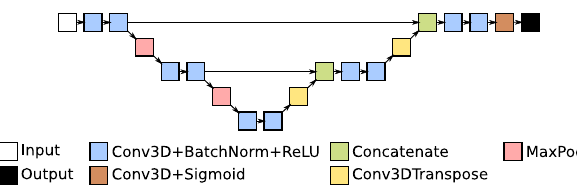
Figure 2. Basic U-Net architecture with three multi-scale layers.